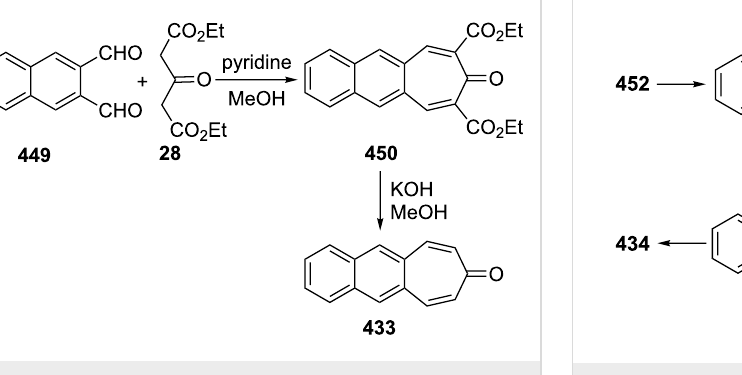
Scheme 83: Synthesis of naphthotropone 434 starting from 452 .